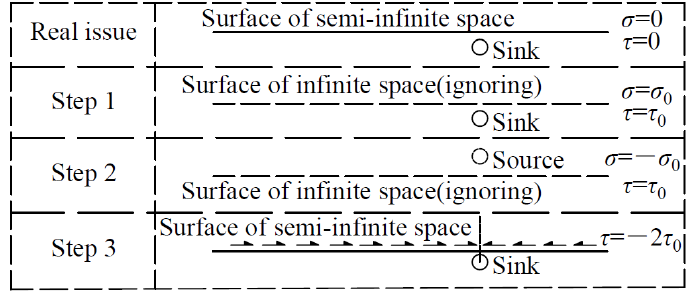
Figure 3. Analysis flow chart of the virtual image technique.